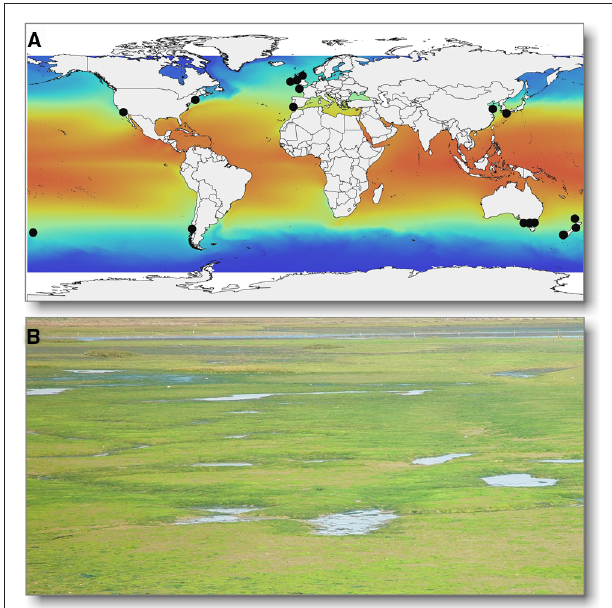
FIGURE 1 | (A) The worldwide distribution of U. compressa and related populations including U. mutabilis (black circles; rbcL haplotypes available through NCBI GenBank) are presented as an example of the cosmopolitan nature of Ulva spp. The sea surface temperature map was plotted using Bio-ORACLE 1 (Tyberghein et al., 2012). (B) Ulva can cause green tides, e.g., in the lagoon Ria Formosa (Portugal). Photo is a courtesy of Dr. Eric-Jan Malta (IFAPA,